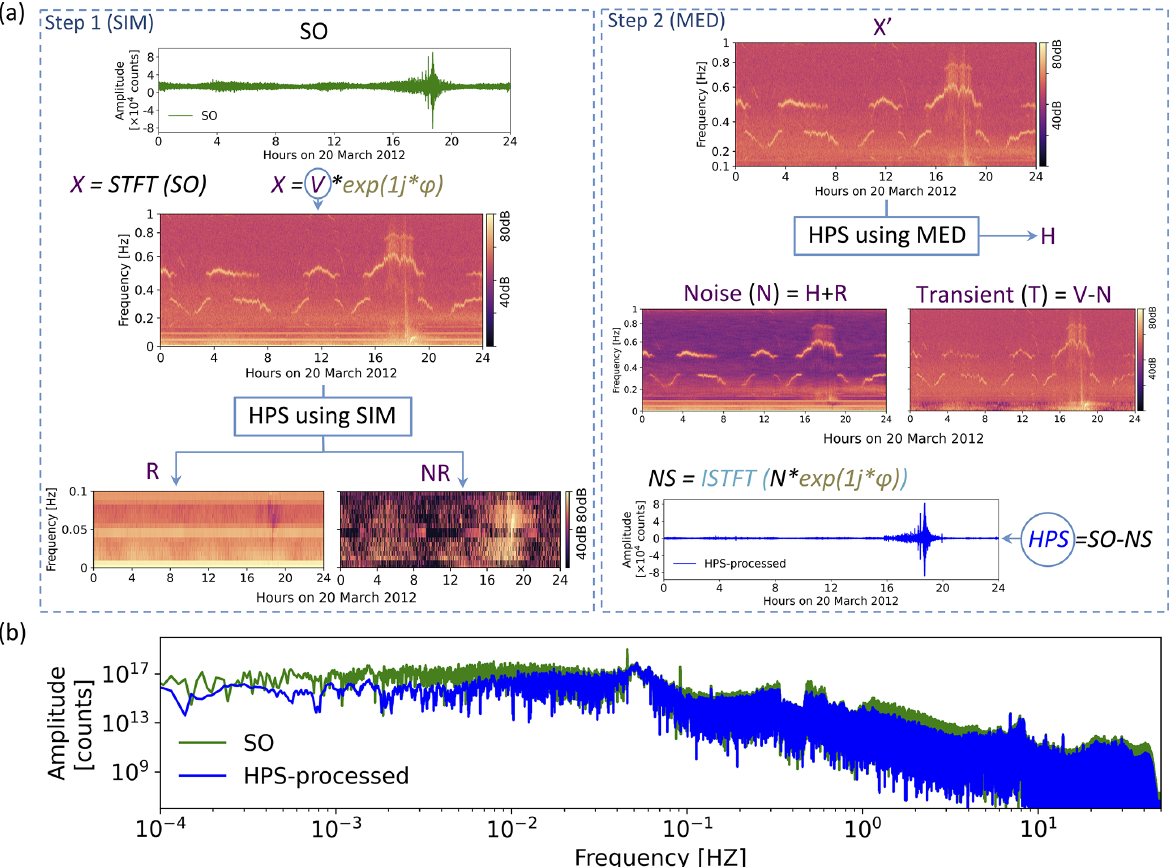
Figure 2. Method flowchart (a) with an illustration of the processing steps with a real data example. The left panel shows the first step of the method; using the similarity matrix (SIM) in the frequency range below 0.1Hz and above 1Hz, we divide the spectrogram ( X ) of the original signal (SO) into two spectrograms of repeating ( R ) and non-repeating ( NR ) patterns. The right panel shows the second step of the method wherein we apply a median filter (MED) to the frequency range of 0.1 to 1Hz (spectrogram X (cid:48) ) in order to remove noises from this frequency range. It results in the harmonic spectrogram ( H ). As the interesting frequency range for OBS signals is below 1Hz, the spectrograms show only this frequency range. Finally, the noise spectrogram ( N ) is created by summing the separated noises derived from two steps, and the noise signal (NS) is derived using ISTFT. We obtain the noise-reduced signal (HPS) by subtracting the NS from the input OBS signal (SO). STFT: short-time Fourier transform. HPS: harmonic–percussive separation. SIM: similarity matrix. MED: median filtering. ISTFT: inverse short-time Fourier transform. (b) Spectrum of the original signal (SO) and the HPS noise-reduced